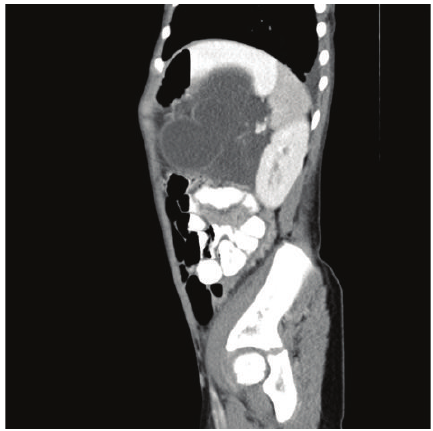
Figure 3: Contrast-enhanced CT sagital scan shows that retroperi- toneal lobulated-septated cystic mass cannot be distinguished from spleen, pancreas, and stomach. Splenic vein and artery borders are in the cystic mass also.